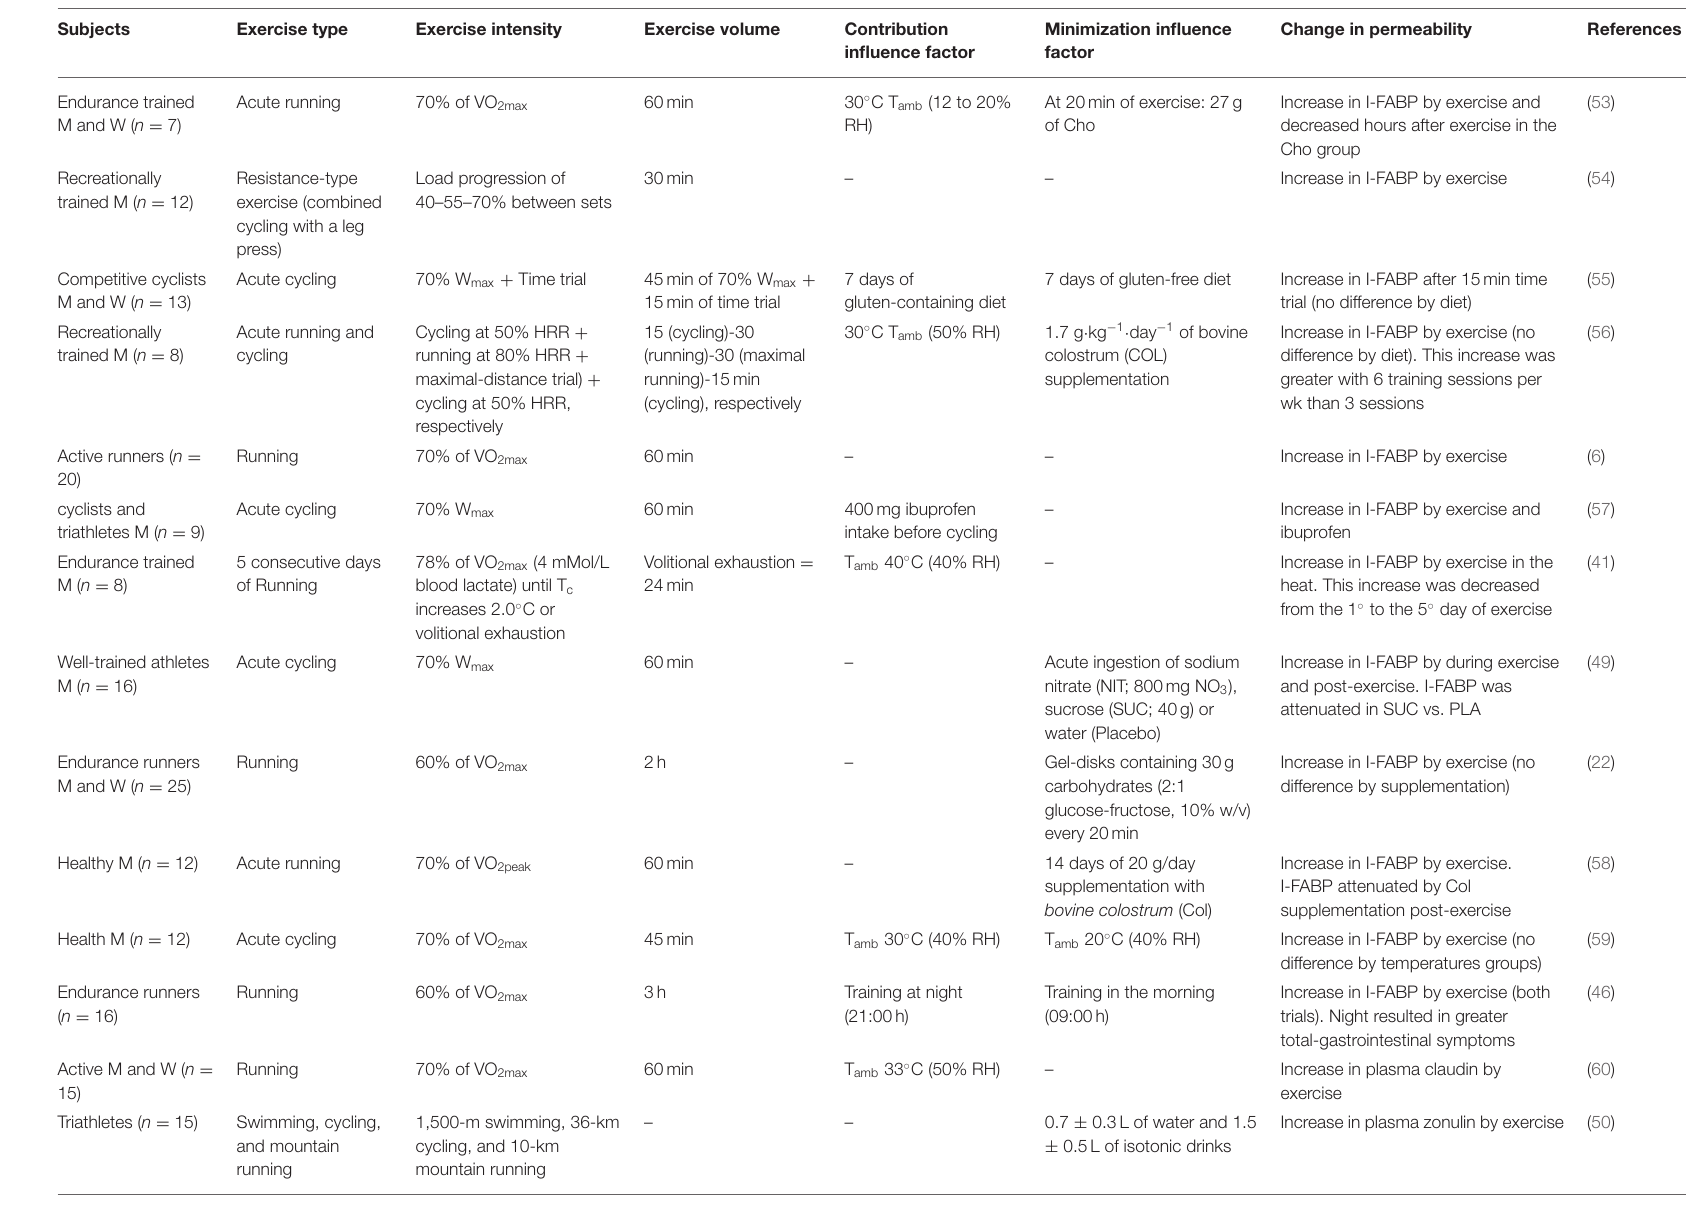
TABLE 1 | Changes in intestinal permeability caused by exercise and the influencing